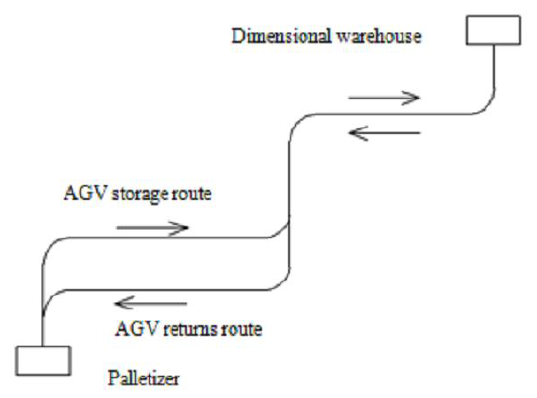
Fig. 1. Layout of automated warehouse system